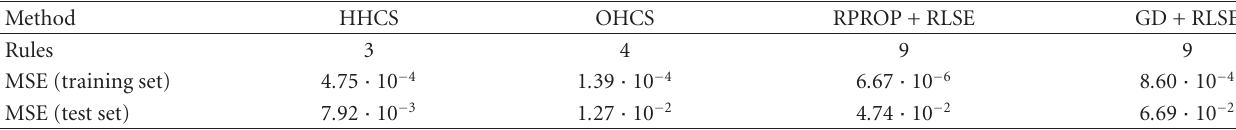
Table 3: Comparison with RPROP + RLSE and GD + RLSE methods.